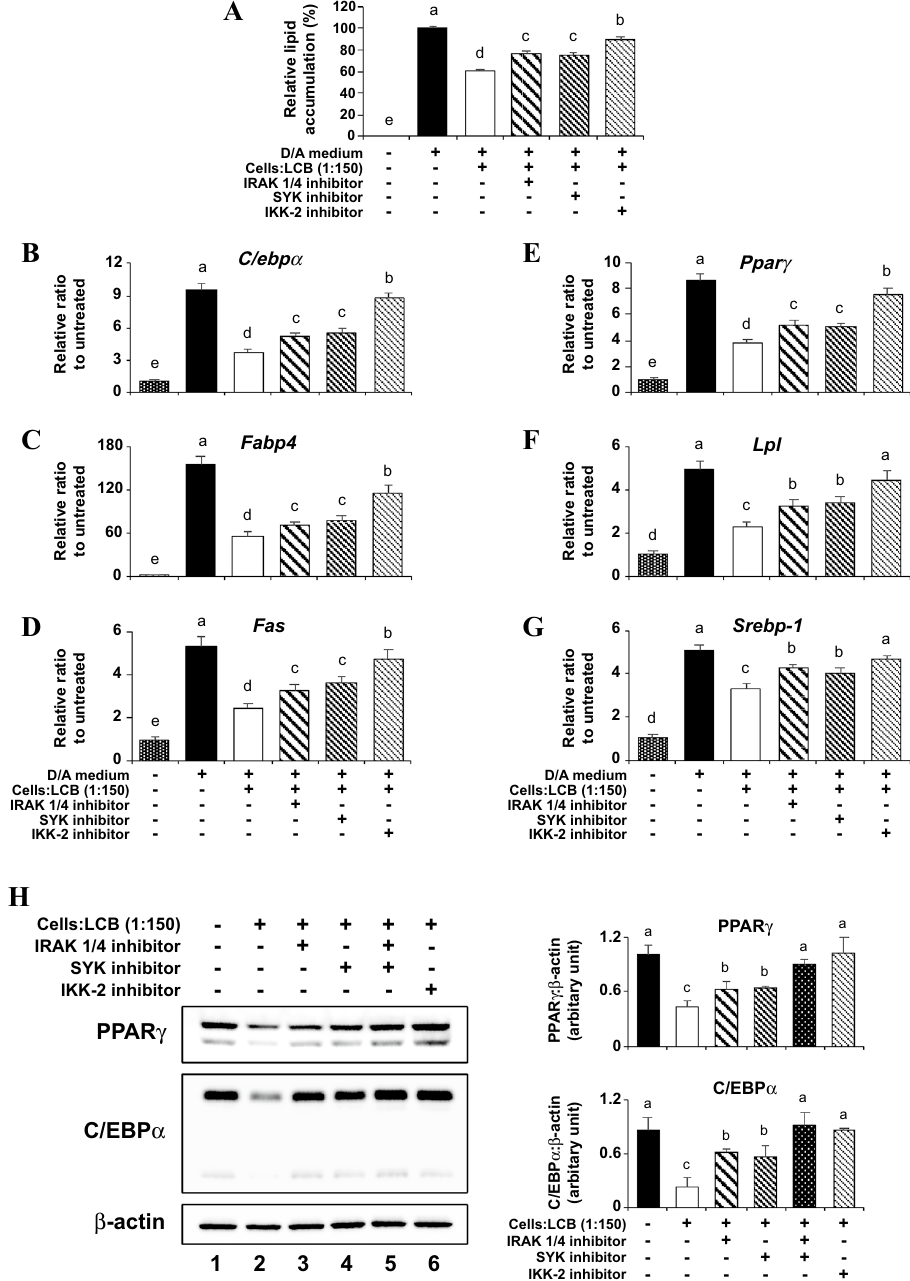
Figure 6. IRAK 1/4 and SYK signaling pathways mediate inflammatory-stimulating and adipogenic suppressing effects of LCB on differentiating 3T3-L1 adipocytes. (A) shows the relative lipid accumulation in preadipocytes (without any treatment), D/A-induced differentiating 3T3-L1 adipocytes, D/A-induced differentiating 3T3-L1 adipocytes treated with 1:150 cells:LCB without or with 10 μM IRAK 1/4, 10 μM SYK, both IRAK 1/4 and SKY, or 50 μM IKK-2/SC-514 inhibitor. Preadipocytes were pre-treated with each inhibitor at the indicated concentration for 30 min. Then, the D/A medium together with LCB (1:150 cells:LCB) in the absence or the presence of each inhibitor were added to the cells and maintained throughout the period of adipogenic differentiation (8 days). At the end of differentiation, cells were collected for the Oil Red O